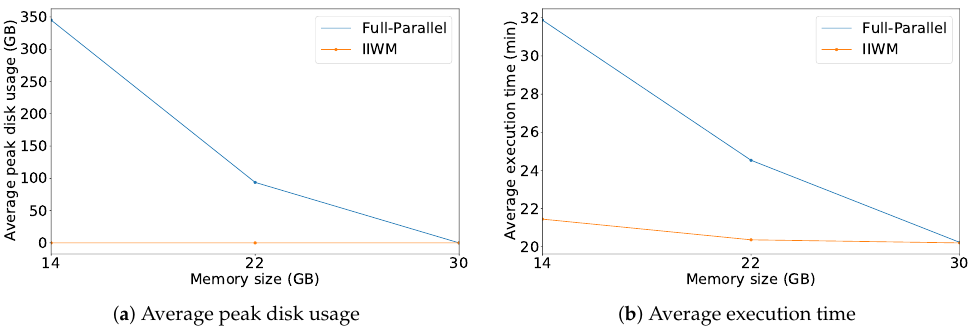
Figure 6. Average peak disk usage and execution time, varying the size of available